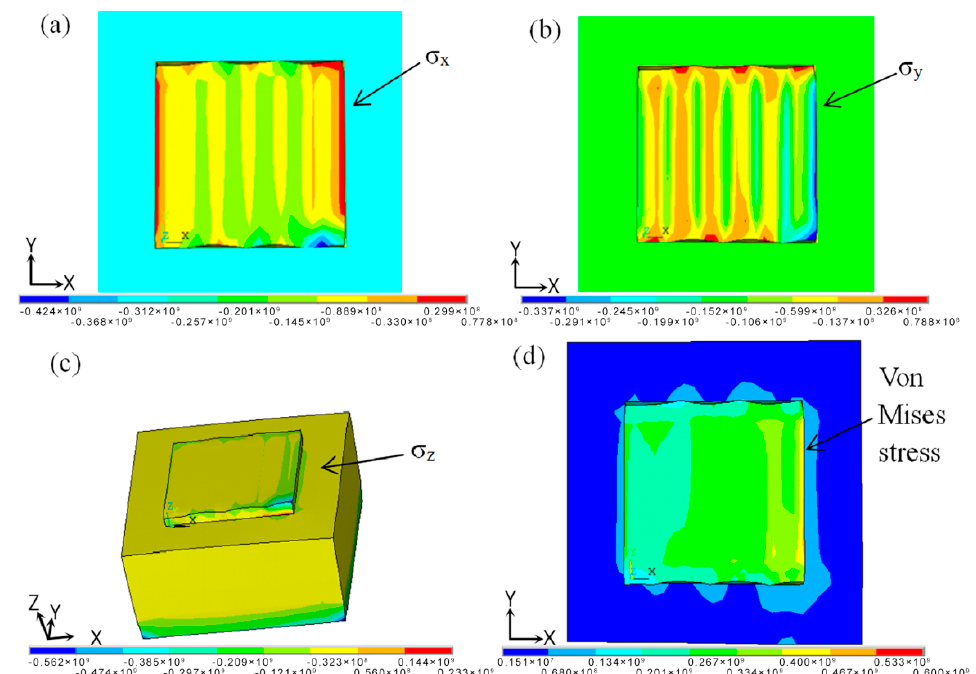
Figure 8. The residual stress fields cooling to room temperature. ( a ) Residual stress σ x distribution; ( b ) Residual stress σ y distribution; ( c ) Residual stress σ z distribution; ( d ) Equivalent stress distribution.